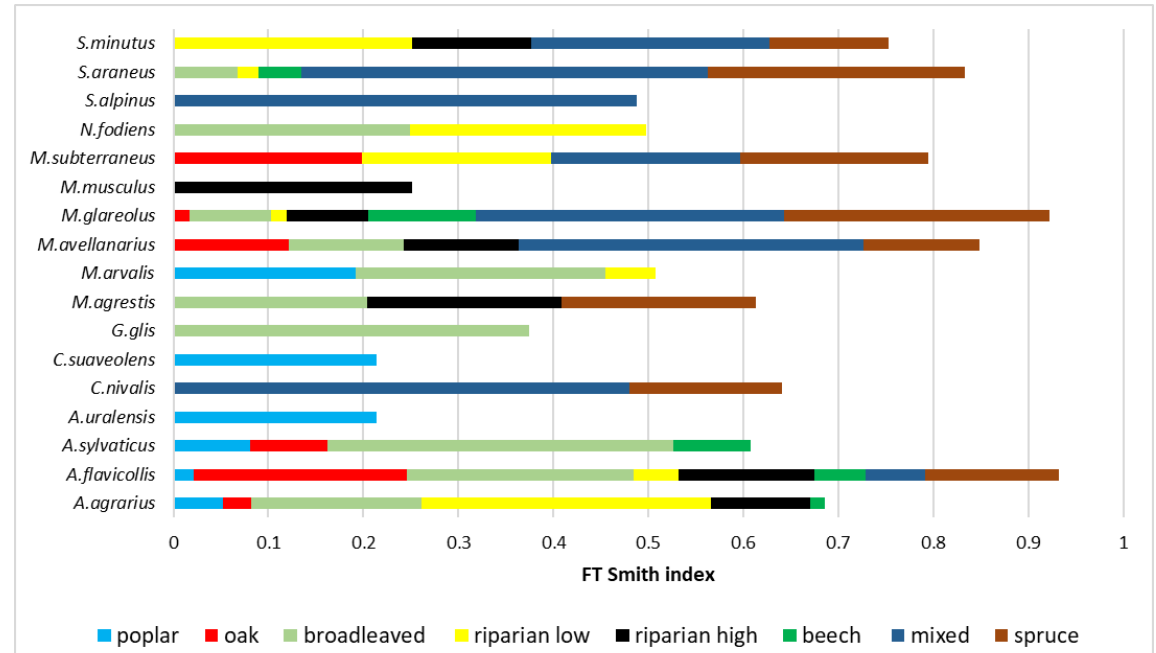
Figure 2. Niche width (expressed by FT Smith niche width index) of small mammal species. For each species, relative occurrence in the eight surveyed forest types is given by colour codes. Riparian forests were divided into two distinct types, those of lowlands (riparian low) and those of mountains (riparian high).